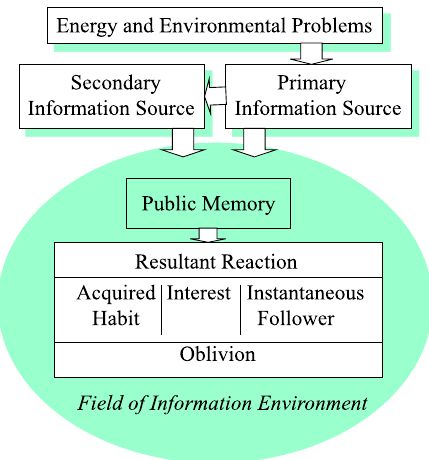
Fig. 4. Conceptual diagram for the ¯eld of information